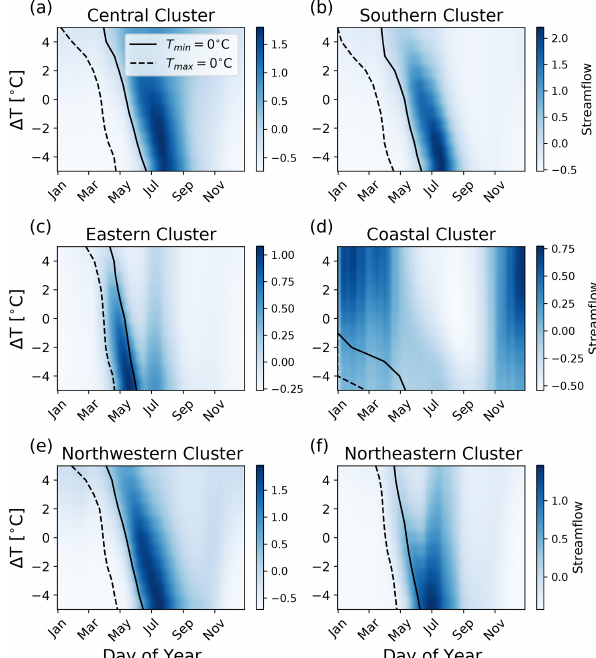
Figure 9. Modelled streamflow for a range of temperature pertur- bations averaged across all stream gauges in each cluster and all years in the test set. Black lines indicate the transition from below- freezing to above-freezing maximum (dashed) and minimum (solid) daily temperatures. In the (a) central, (b) southern, (c) eastern, (e) northwestern, and (f) northeastern clusters, (cid:49)T > 0 ◦ C leads to an earlier freshet with a smaller peak flow, while (cid:49)T < 0 ◦ C leads to a later freshet with a larger peak flow. In the (d) coastal cluster, (cid:49)T > 0 ◦ C leads to enhanced streamflow in winter and fall and suppressed streamflow in summer, while (cid:49)T < 0 ◦ C leads to sup- pressed streamflow in winter and fall and enhanced streamflow in